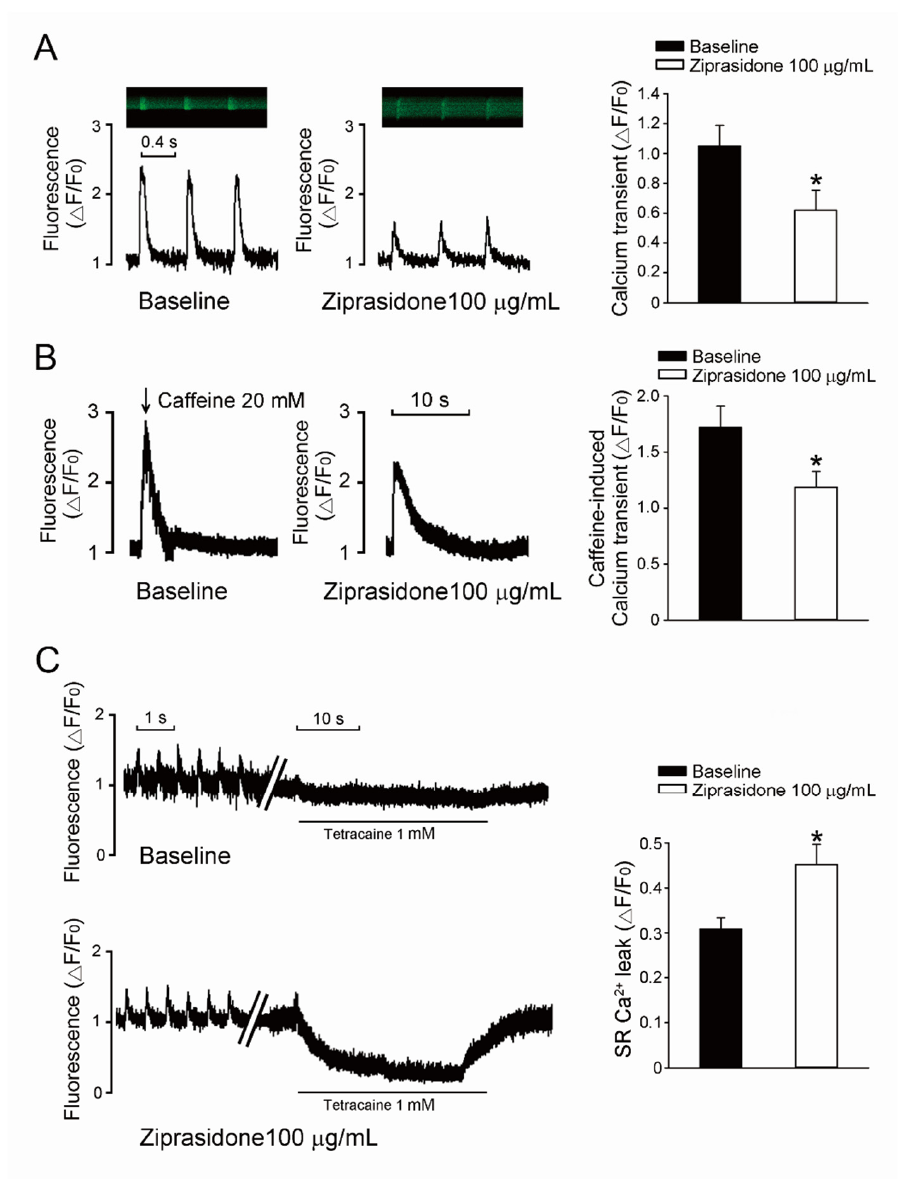
Figure 4. SR Ca 2+ leak. ( A ): Typical traces of steady-state Ca 2+ transient in atrial myocytes treated with or without ziprasidone, and mean data (baseline group n = 22/3, ziprasidone group n = 30/3; * p < 0.05). ( B ): A: Typical traces of caffeine-provoked Ca 2+ transient in atrial myocytes treated with or without ziprasidone, and mean data (baseline group n = 22/3, ziprasidone group n = 16/3; * p < 0.05). ( C ): Typical recording of SR Ca 2+ leakage determined by fast tetracaine application in atrial myocytes treated with or without ziprasidone, and mean data (baseline group n = 13/3, ziprasidone group n = 12/3; * p < 0.05).